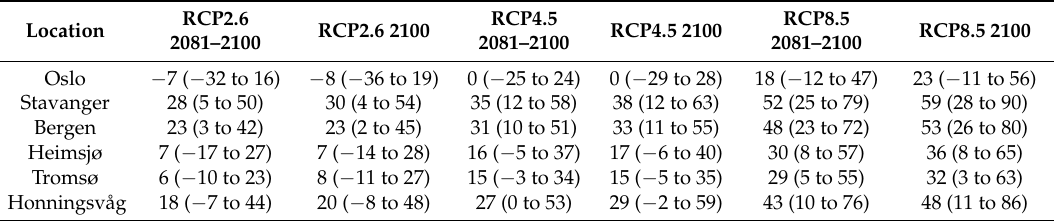
Figure 9. Projected ensemble mean relative sea-level change (m) for the 290 coastal municipalities in Norway over the period 1986–2005 to 2081–2100 for: ( a ) RCP2.6; ( b ) RCP4.5; and ( c ) RCP8.5. Table 2. Comparison of mean relative sea-level projections at six key locations for the period 1986–2005 to 2081–2100 and the period 1986–2005 to 2100. The 5% to 95% ensemble spread is given in the parentheses. Units are in centimetres.